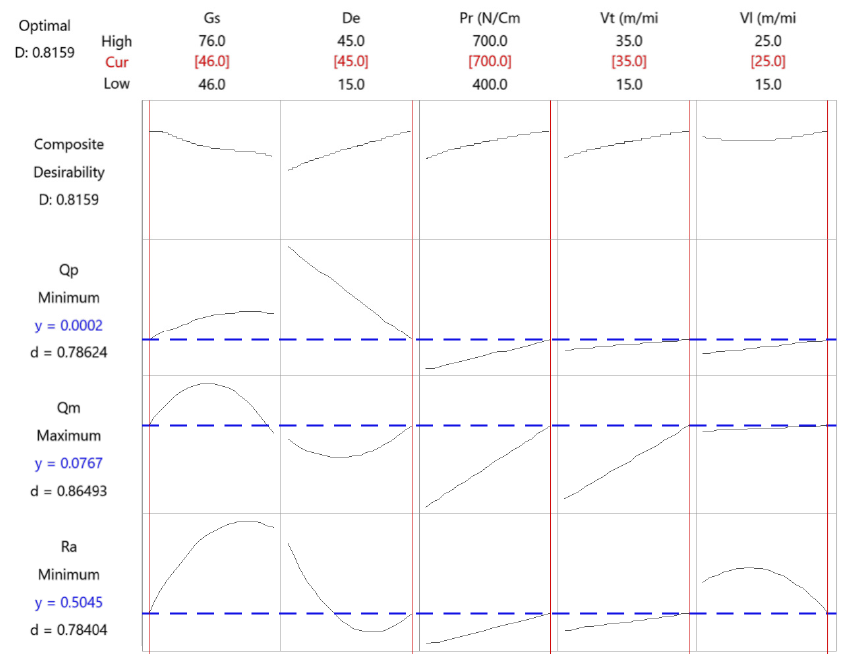
Figure 11. Multi-objective optimization of the semi-finish honing operation.